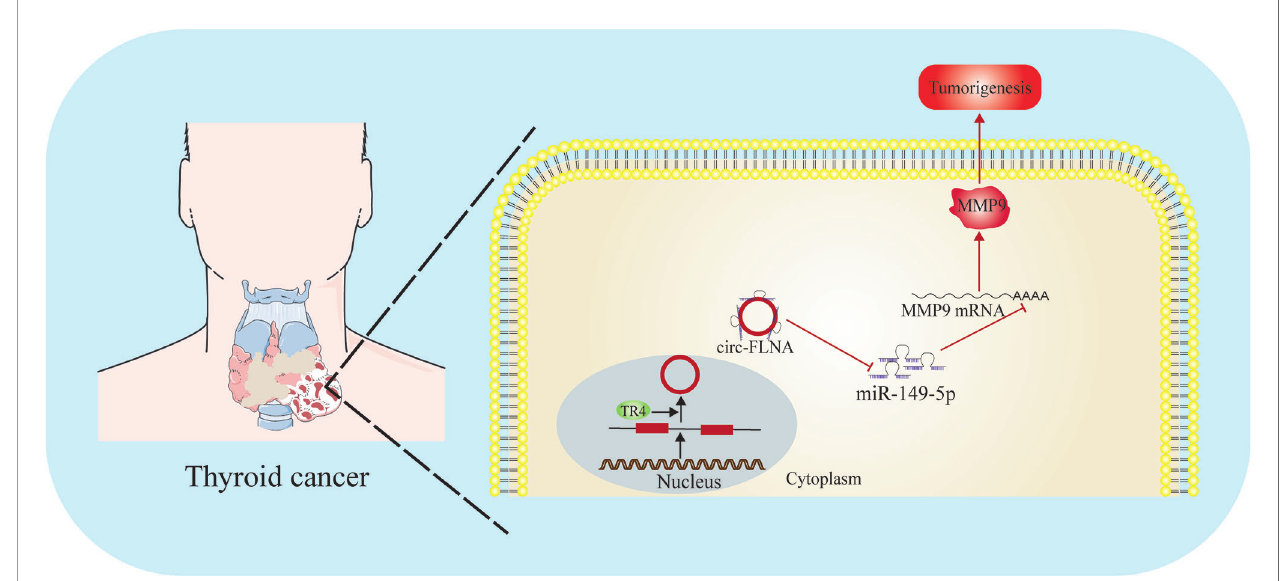
FIGURE 4 | Function and regulatory mechanism of miR-149-5p in thyroid cancer. MiR-149-5p inhibits thyroid cancer progression through targeting MMP9, and is sponged by